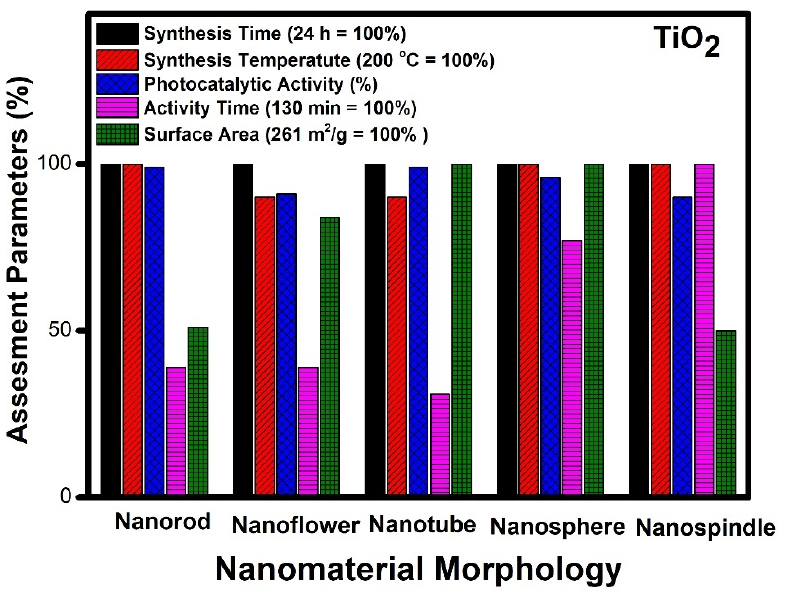
Figure 2. Assessment of different morphologies of TiO 2 based on various parameters.